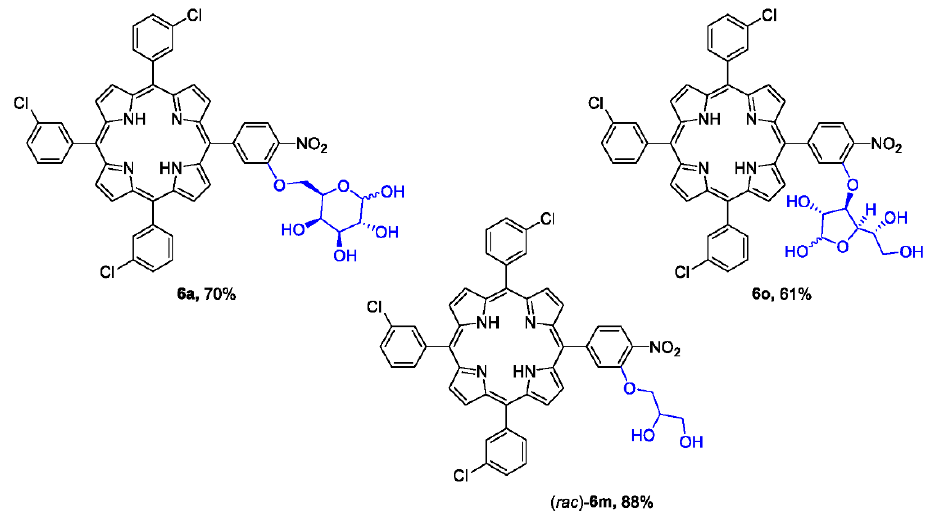
Figure 1. The structures of final products and the yields of the deprotection steps. The reaction was conducted at 50 °C for 3 h in 35% HCl (aq) .